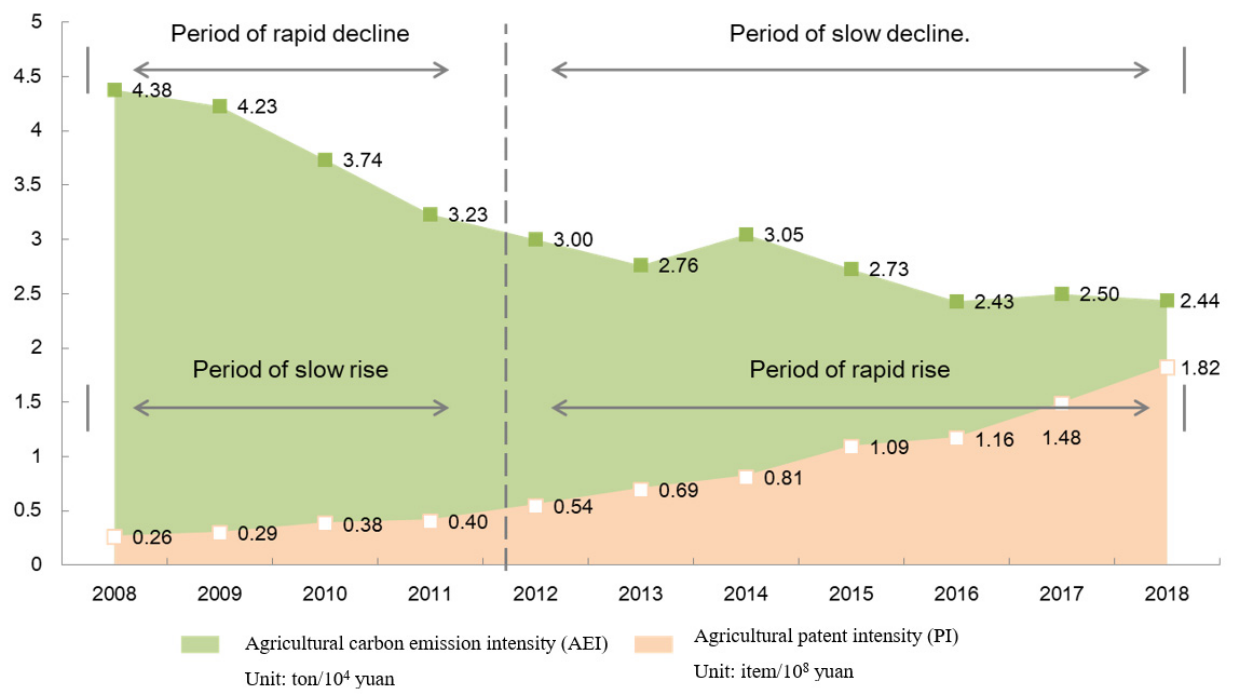
Figure 3. The trend of agricultural carbon emission intensity and patent intensity.